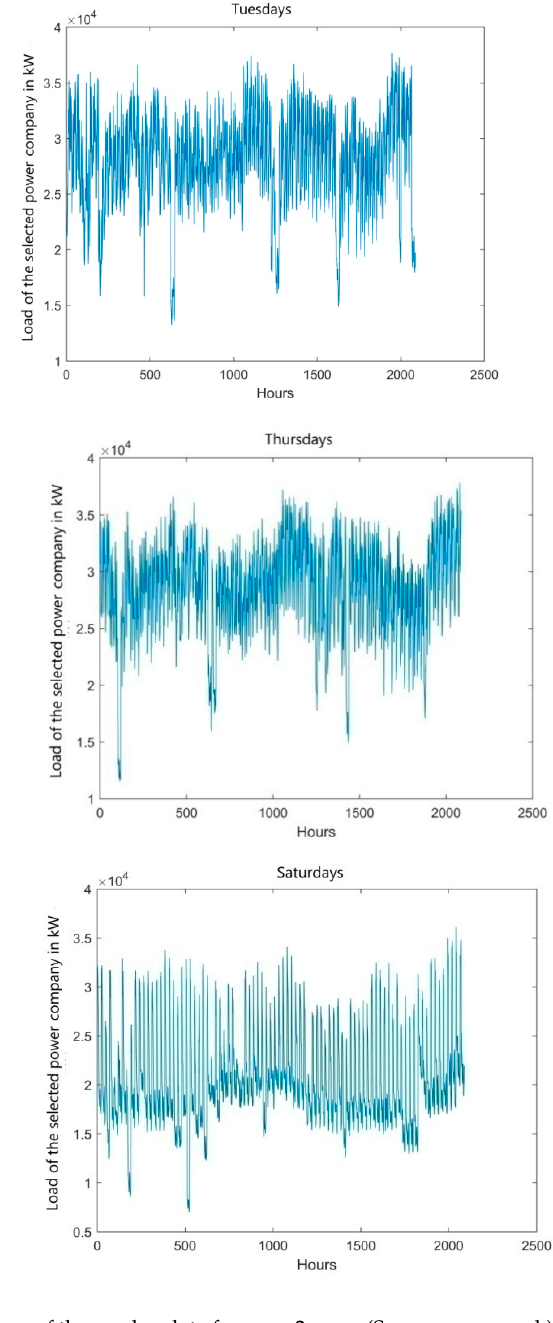
Figure 4. Load of the selected power company within subsequent days of the week—data from ca. 2 years (Source: own work). Table 1. Integral capacities of information carriers for the selected sets of exogenous